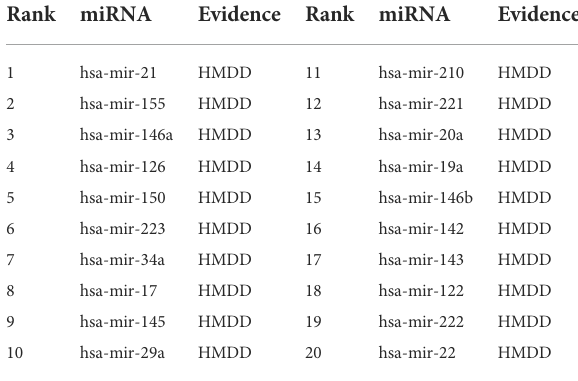
TABLE 6 Top 20 miRNA candidates related to lymphoma. Rank miRNA